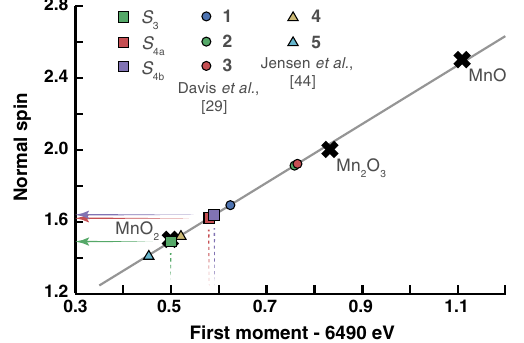
FIG. 4. Analysis of Mn K β first moments. Placement of fully processed 2 F and 3 F data along a linear fit to a series of Mn oxide first moments empirically predicts the average spin state of Mn centers in the OEC. For reference, relevant Mn coordination complexes are placed along the line by using the nominal spins reported by Davis et al. and Jensen et al. [31,46]. Note that S 4 a and S 3 F states with Δ t betweenthe final laserflash and 4 b correspond to an x-ray pulse of 50 and 200 μ s, respectively. Compounds 1 – 3 are formally mixed valence Mn III = Mn IV complexes. 1 is a di- μ -oxo dimer, [Mn 2 O 2 L 0 4 ] ð ClO 4 Þ 3 , while 2 and 3 are two examples from the Mn cubane family, Mn 4 O 4 L 6 . Compounds 4 and 5, by contrast, are mononuclear Mn complexes ½ Mn IV ð OH Þ 2 ð Me 2 EBC Þ(cid:3) 2 þ and ½ Mn IV ð O Þð OH Þ − ð Me Þ(cid:3) þ , 2 EBC